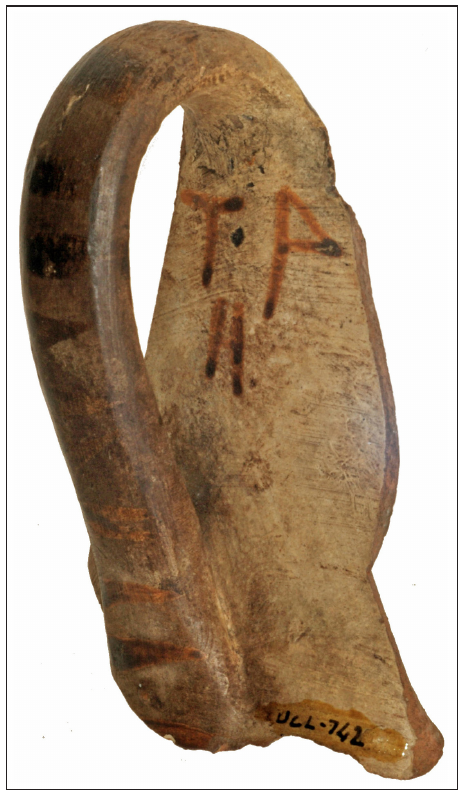
Fig. 4: UCL-742. Chian kantharos. Max, dim. 8 cm. Courtesy of UCL Institute of Archae- ology Collections.